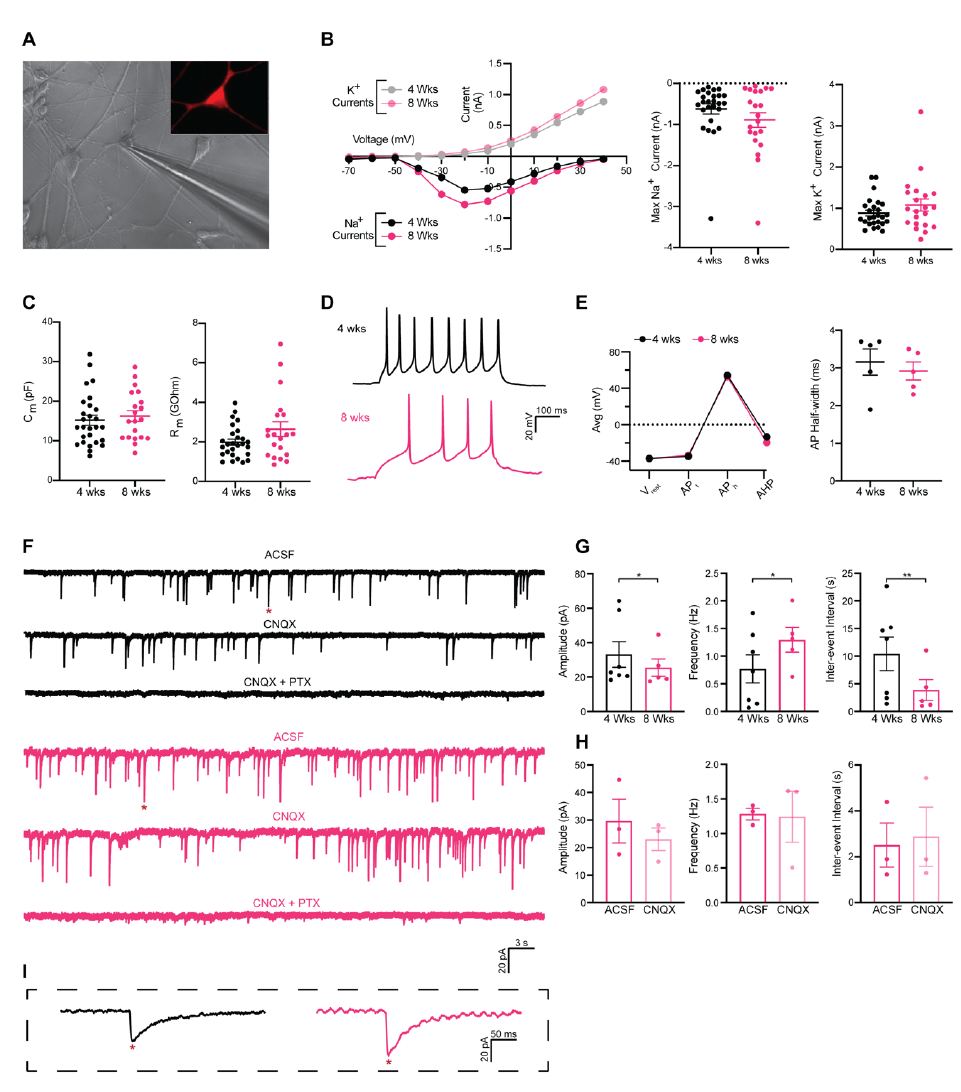
Figure 3. Physiological properties of iNs converted with ADLSF at four weeks and eight weeks. ( A ) Representative image of Syn-RFP + cell in whole cell patch-clamp configuration. ( B ) Inward Na + and outward K + currents plotted against stepwise voltage induction at four weeks (4 wks, black / grey) and eight weeks (8 wks, magenta / pink). Each dot representing the mean value (n = 26 cells, 4 wks and n = 21 cells, 8 wks). ( C ) Measured intrinsic membrane properties, input resistance (left) and membrane capacitance (right). All values are presented as mean ± SEM (n = 27 cells, 4 wks and n = 20 cells, 8 wks). ( D ) Representative trace of repetitive action potentials (APs) evoked by rheobase current injection steps, 4 wks (black) 8 wks (magenta). ( E ) AP properties, resting membrane potential (V rest ), AP threshold (AP t ) AP amplitude (AP h ) and after-hyperpolarization (AHP, left). Each dot representing the mean value (n = 5 cells, 4 wks and n = 5 cells, 8 wks). Half-width of the first evoked AP (right). Values are presented as mean ± SEM (n = 5 cells, 4 wks and n = 5 cells, 8 wks). ( F ) Sample traces of postsynaptic activity blocked with 50 µ M CNQX and 50 µ M CNQX + 100 µ M PTX at 4 wks (black) and 8 wks (magenta). ( G ) Amplitude, frequency, and interevent interval of postsynaptic activity at 4 wks and 8 wks. Values are mean ± SEM (n = 7 cells, 4 wks and n = 5 cells, 8 wks). ( H ) Amplitude, frequency, and interevent interval of postsynaptic activity at 8 wks ACSF and ACSF + 50 µ M CNQX. Values are presented as mean ± SEM (n = 3 cells). ( I ) Magnification of representative inhibitory postsynaptic events (red asterisk) at four weeks (black) and eight weeks (magenta). Two-tailed, unpaired Mann–Whitney (** p < 0.01; * p < 0.05) was used for all comparisons except postsynaptic activity with antagonist (CNQX), where paired Wilcoxon rank-sum tests were performed. See also Figure